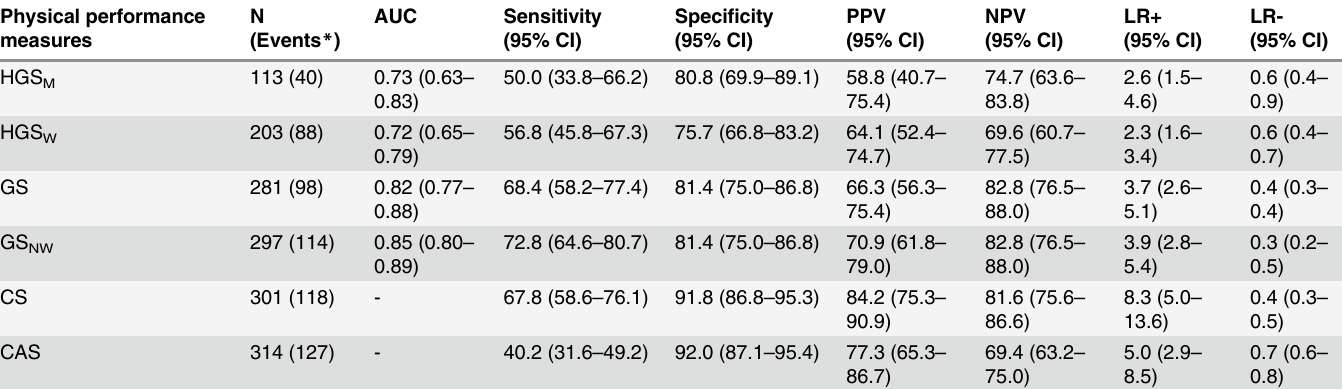
Table 3. Prognostic accuracy for mobility limitations in older medical patients 30 days after discharge. Physical performance